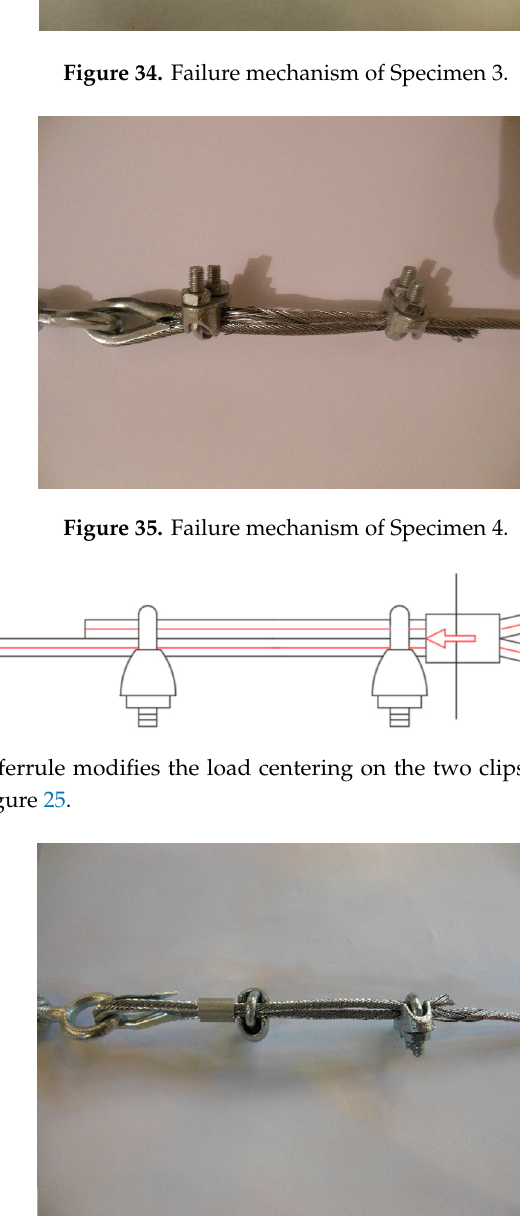
Figure 37. Failure mechanism of Specimen 5.